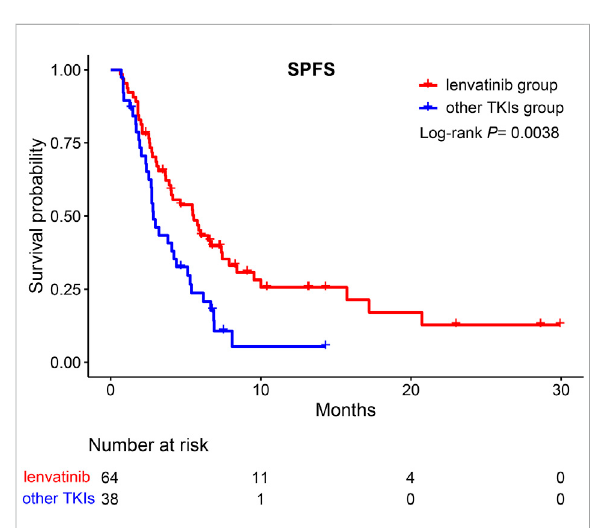
FIGURE 6 Kaplan-Meier curves for SPFS of patients moving to second- line therapy. SPFS, second progression-free survival; TKIs, tyrosine kinase